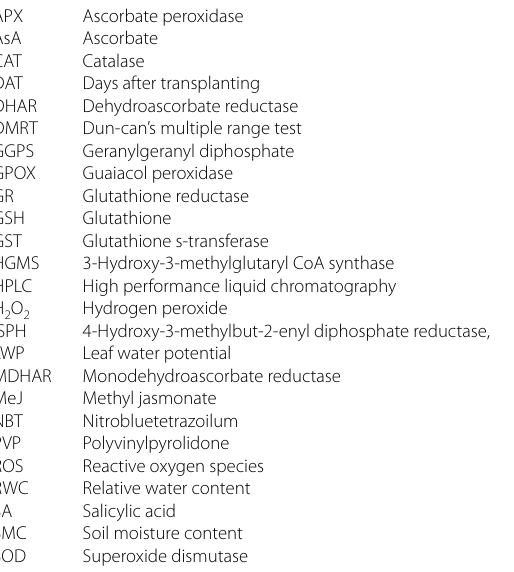
Fig. 2 The values of Pearson’s r is indicated through a heat map. The Pearson’s r ( water content), LWP MPa (Leaf water potential), SOD U (Superoxide dismutase), GPOX uM/min/g (Guaiacol peroxidase), CAT µM/min/g (Catalase), APX uM/min/g (Ascorbate peroxiadase), Chl a (Chlorophyll a mg − 1 FW), Chl b (Chlorophyll b mg g − 1 FW), total chl (Total Chlorophyll mg g − 1 FW), Carot. (Carotenoids mg g − 1 ) FW, PH (Plant height, cm), DHY (Dry herbage yield, g plant − 1 ), Andr. Conc. (Andrographolide concentration %) and Andro Yield (Andrographolide Yield mg Plant. − 1